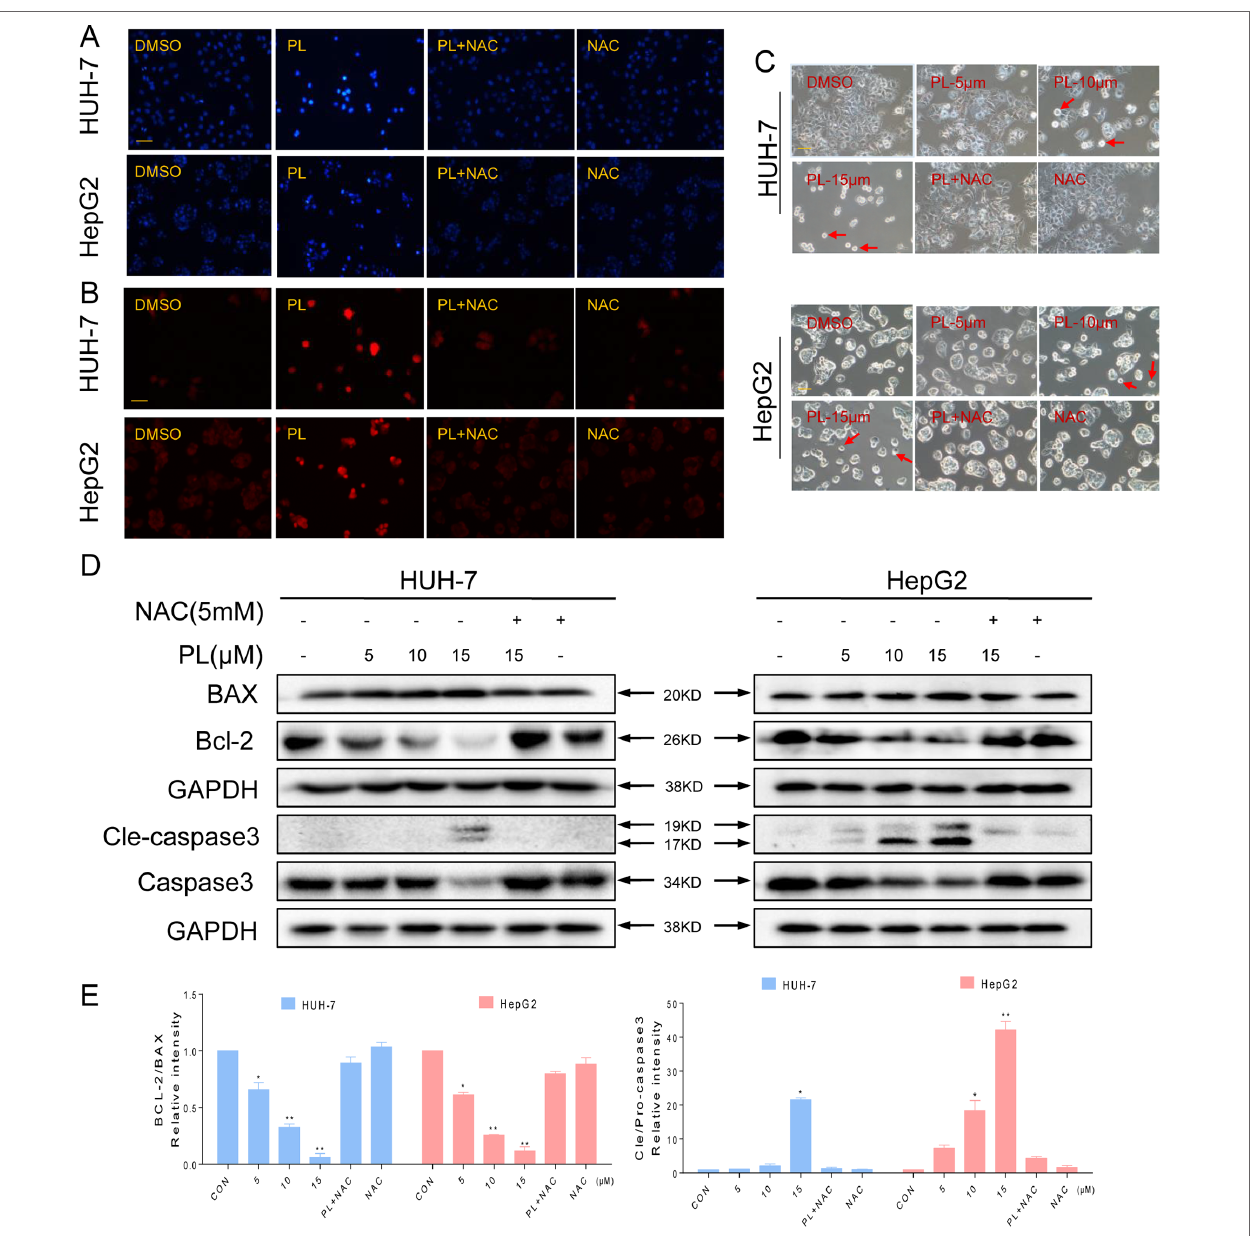
FIGURE 2 | PL-induced apoptosis is dependent on intracellular ROS generation in HCC cells. (A–C) PL treatment induces apoptotic characteristics in HCC cells. Magnification, 200×. Bar, 100 µm. HCC cells were preincubated with or without 5 mM NAC for 2 h before exposure to PL (15 μM) for 24 h. Cell morphology was observed using an inverted microscope after Hoechst and PI staining. (D) Two HCC cell lines were preincubated with or without 5 mM NAC for 2 h before exposure to PL at the indicated concentration for 24 h, and apoptosis-related protein expression was determined by western blotting. Data represent similar results from three independent experiments. (E) Western blot results from (D) were calculated and compared with the BAX or caspase3. Western blot results were calculated and represent the percentage of the control (*p < 0.05, **p < 0.01). All images shown here are representative of three independent experiments with similar